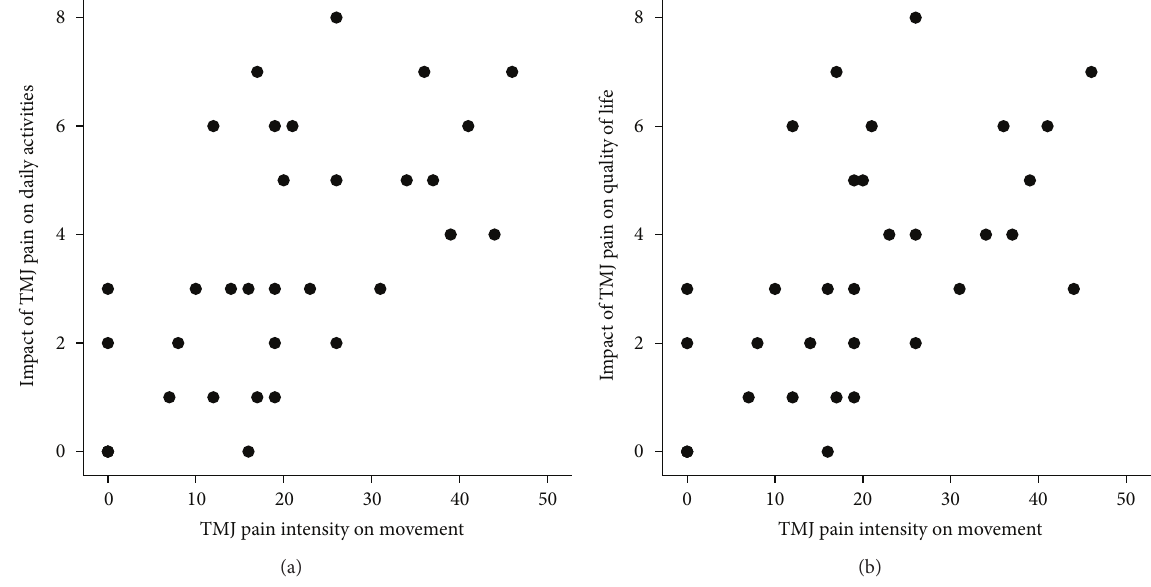
NRS: numerical rating scale to assess the impact of TMJ pain on the patients abilities to perform daily activities and on the quality of their life on a 0–10 NRS where 0 corresponded to “no impact of TMJ pain on daily activities/quality of life” and 10 corresponded to “maximum impact of the TMJ pain on daily activities/quality of life.” A NRS was also used to assess the TMJ pain intensity where 0 corresponded to “no pain” and 10 to “worst imaginable pain.”